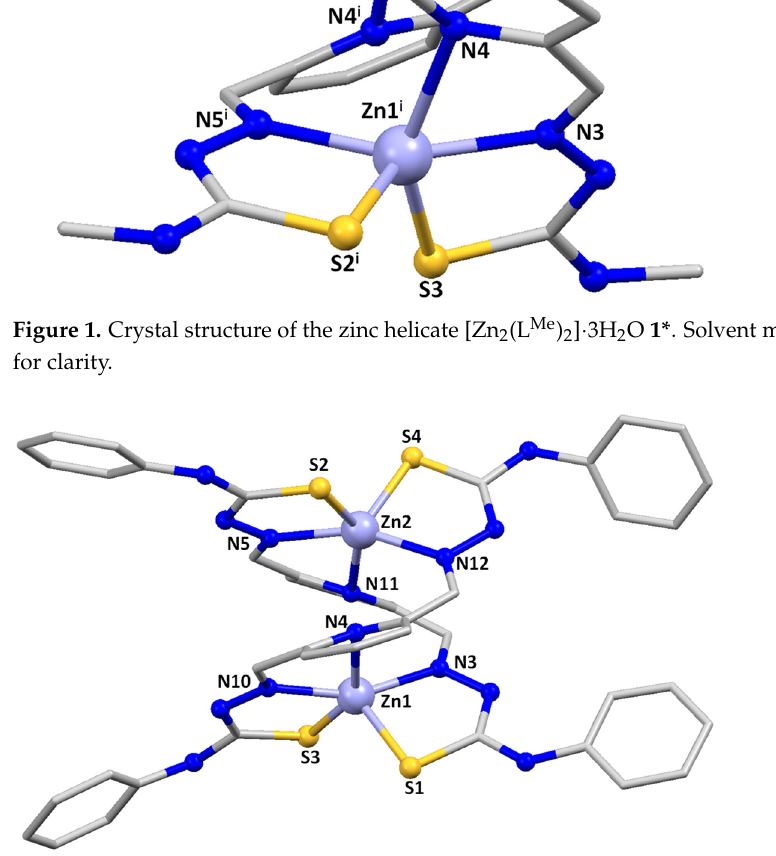
Figure 2. Crystal structure of the zinc helicate [Zn 2 (L Ph ) 2 ] · 4CH 3 CN 2* . Solvent molecules were omitted for clarity.